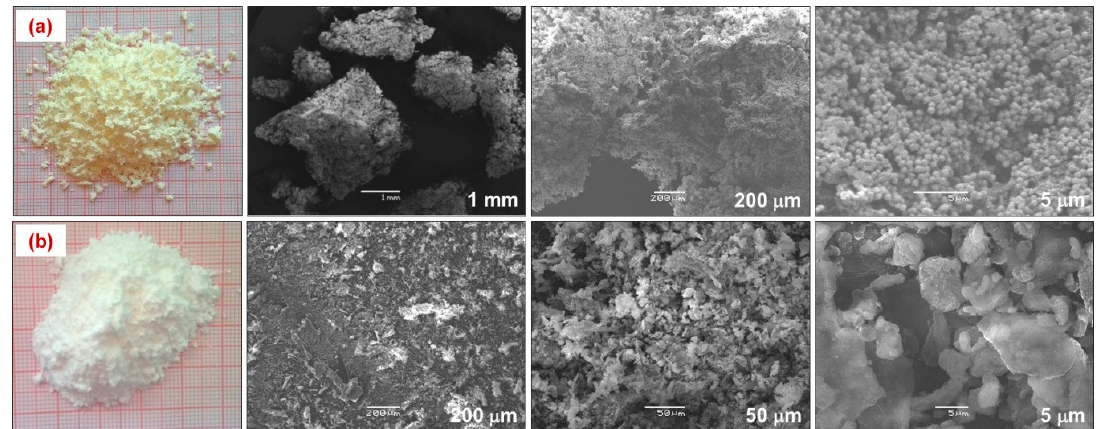
Figure 5. Photographs and SEM images at different magnifications of PUA powders prepared from Desmodur N3300 and water in propylene carbonate ( a ) or acetone ( b ) via vigorous agitation of the sol (monomer concentration: 5.5% w/w). Scale lengths are indicated in the right-bottom corner of each frame.